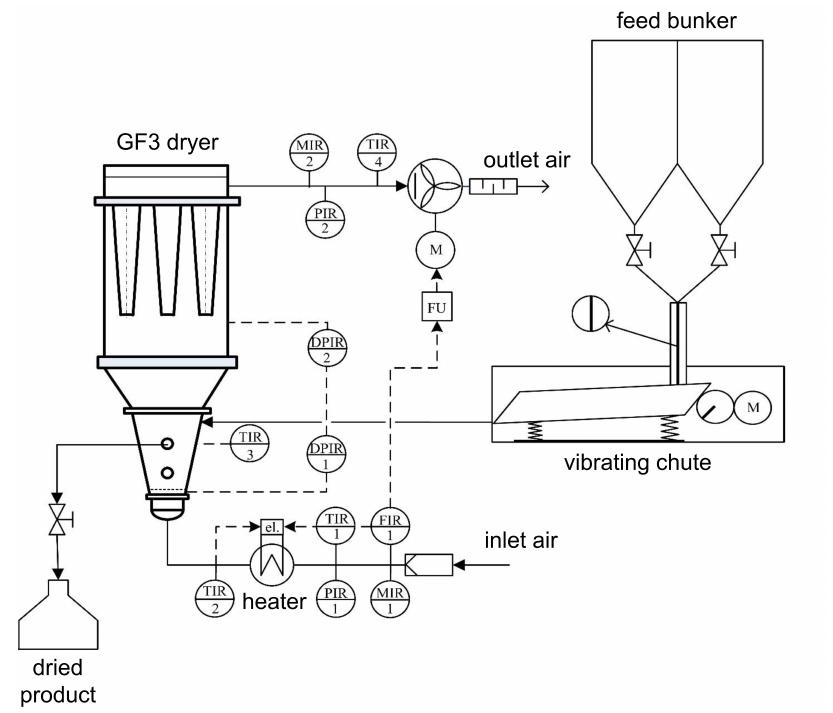
Figure 4. Simplified flow chart of the continuous lab-scale dryer, including measurement locations (modified from [36]); outflow holes in the dryer wall are available at 7 and 12cm above the distributor. Table 2. Overview of investigated process parameters and inlet conditions of experiments and simulations for model validation; including reference names for every